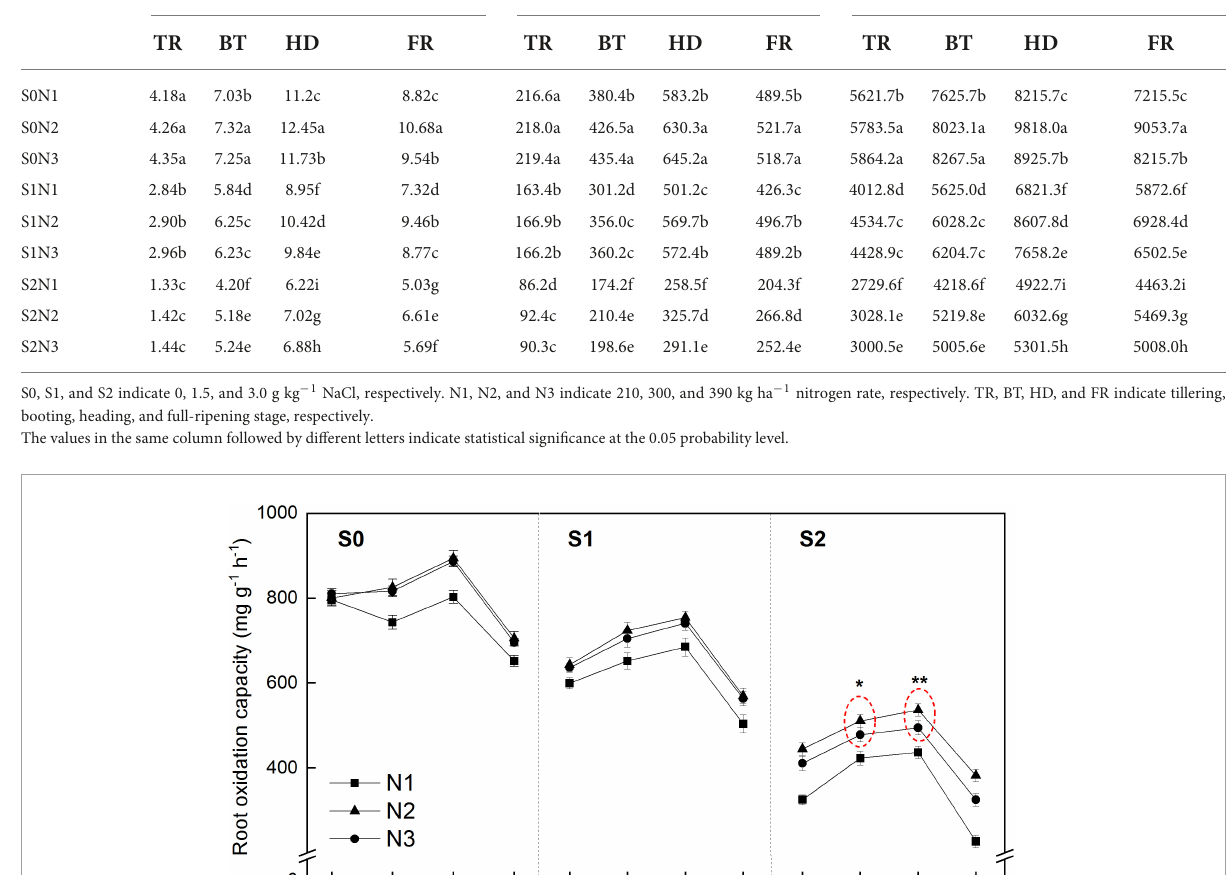
TABLE 3 Effects of different salt concentrations and nitrogen rates on rice root morphological traits. Treatment